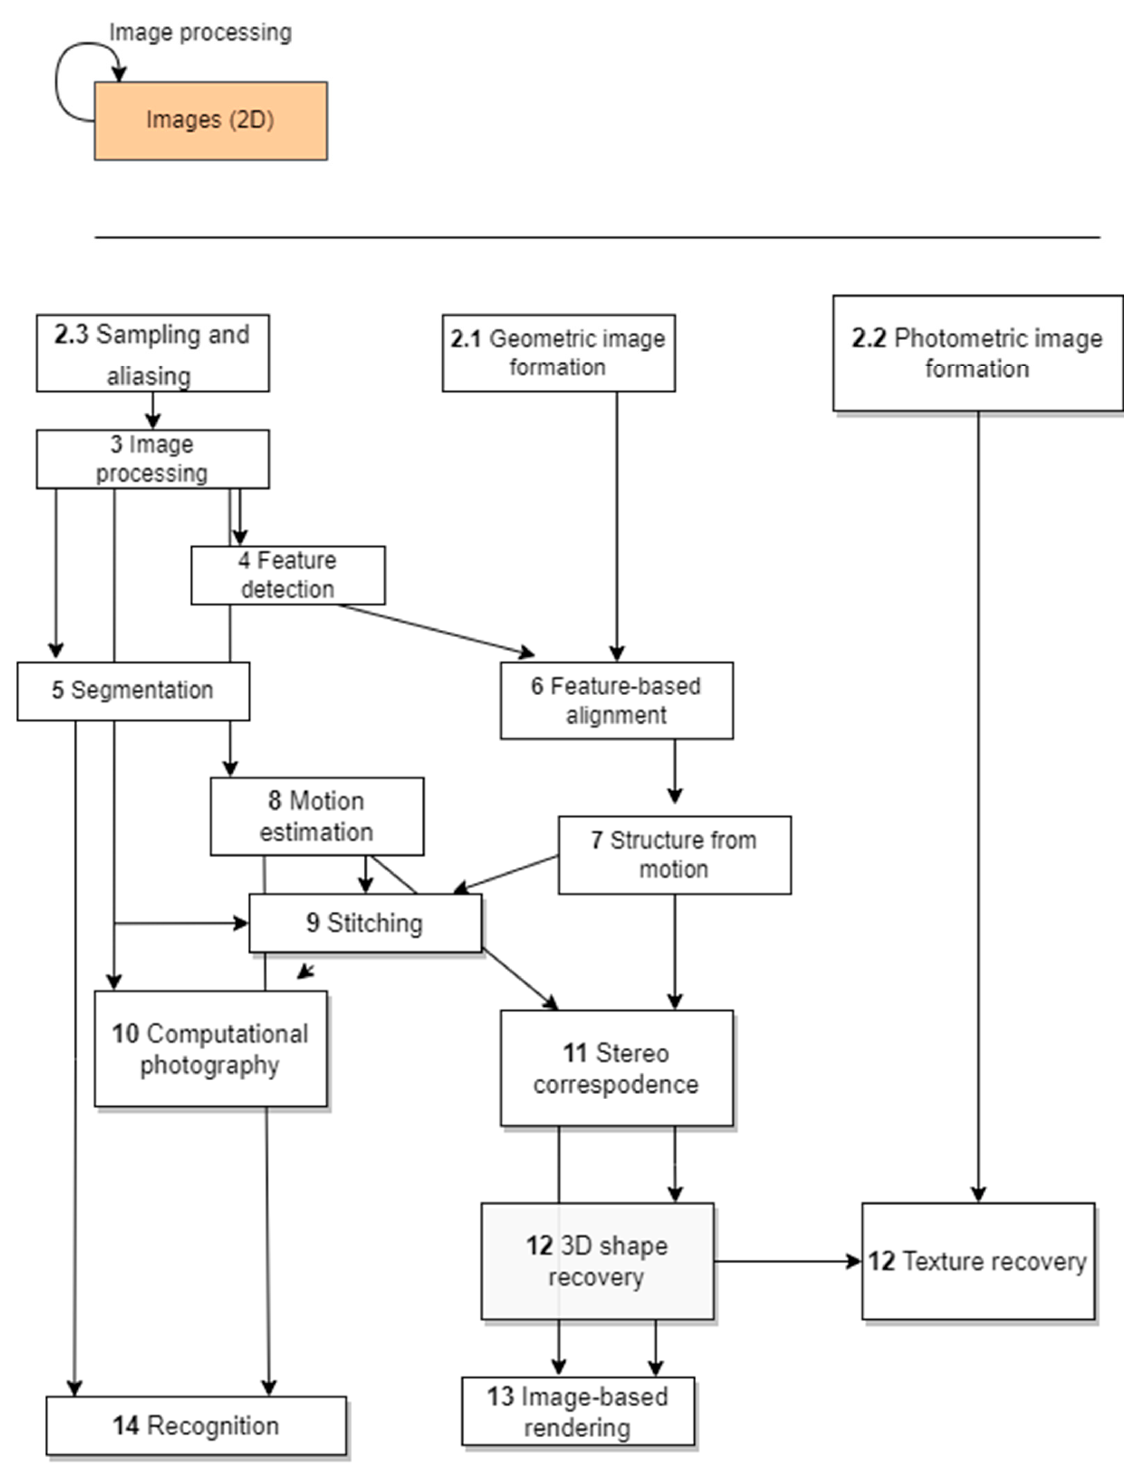
Figure 3. UML Communication Diagram for Image Processing Module.